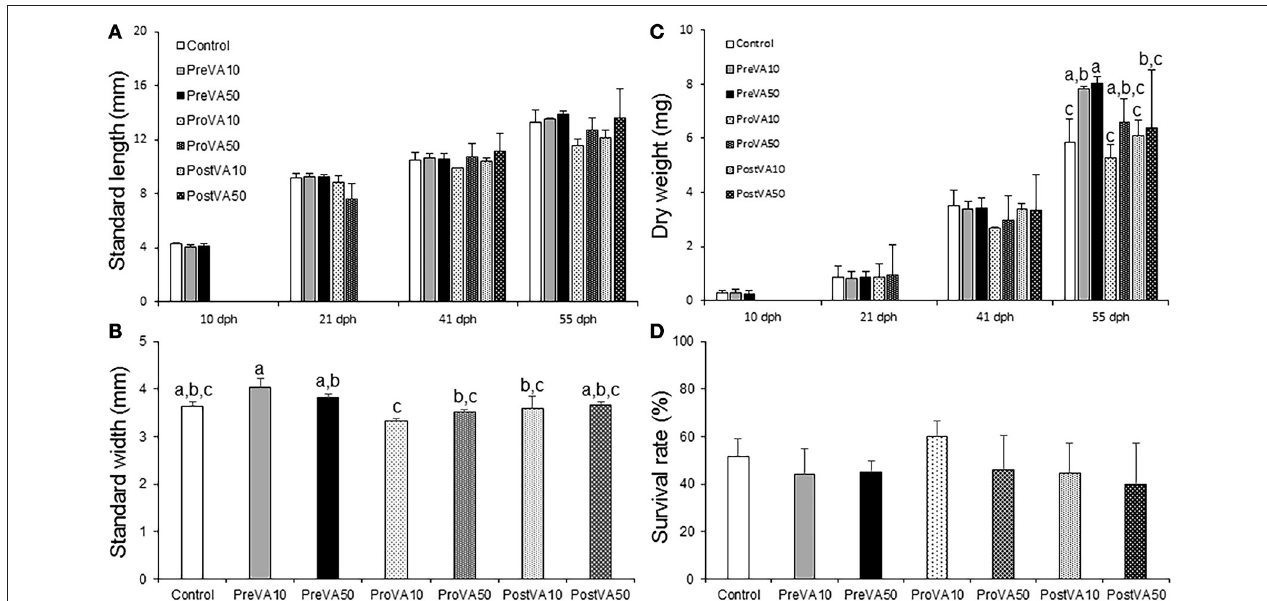
FIGURE 2 | Larval performance (growth and survival; mean ± standard deviation) in Senegalese sole fed the different experimental diets. Standard length at 10, 21, 41, and 55 dph (A) , standard width at 55 dph (B) , dry weight at 10, 21, 41, and 55 dph (C) and survival rate at 55 dph. For a detailed description about the different experimental groups, please see the legend of Figure 1 . Different letters at the top of each bar denote statistically significant differences among experimental groups (ANOVA, P < 0.05; N = 3).